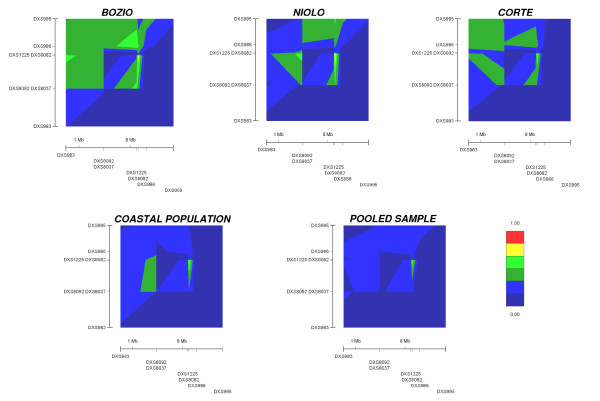
Graphical display of LD for Xq13-21 microsatellite pairs, estimated as multiallelic corrected D' in the different Corsican sub-populations. Distances (Mb) used for drawing the plots by the GOLD program are reported in Table 1. Colours reflect corrected D' values from red (D' = 1) to deep blue (D' = 0). Patterns of LD for Bozio, Niolo and Corte sub-populations appear slightly different from the distributions shown in Latini et al. [15], due to the updated Ensembl physical map.